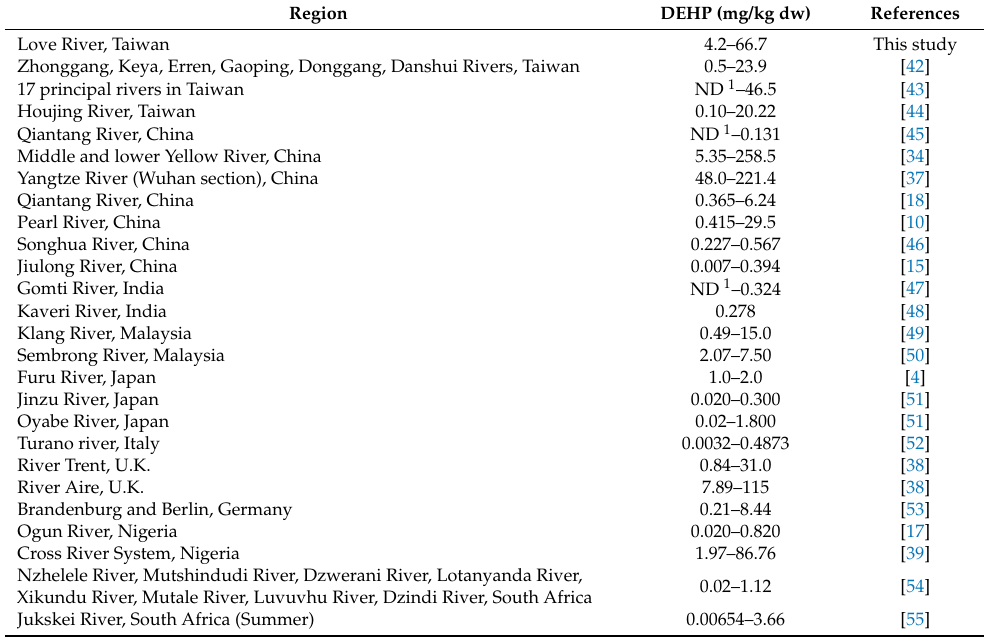
Table 2. Comparisons of the DEHP concentrations in the sediments of Love River with those of rivers in other